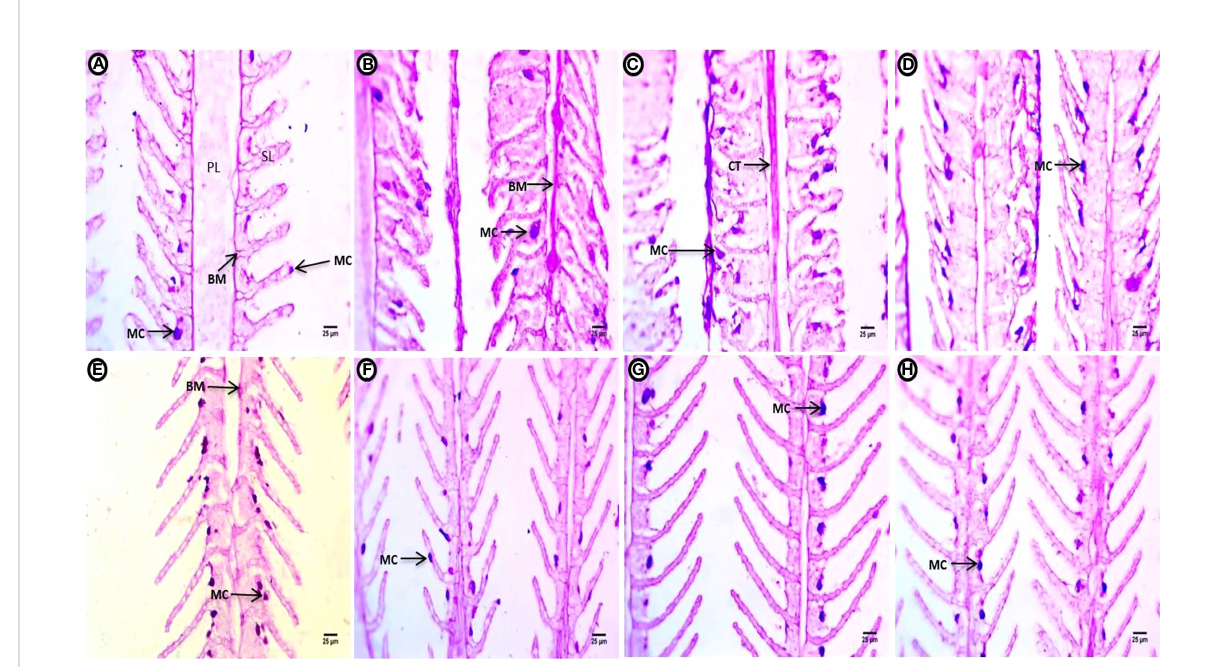
FIGURE 2 Gill sections (PAS reaction showing polysaccharides) of common carp showing the control group, and after treatment with 10 mg/L PE-MPs, 10 mg/L PE-MPs + 200 µg/L 4-NP, and 200 µg/L 4-NP, as (A – D) for exposure and (E – H) for post exposure, respectively. Primary lamellae (PL), secondary lamellae (SL), connective tissue (CT), basement membrane (BM), and mucous cell